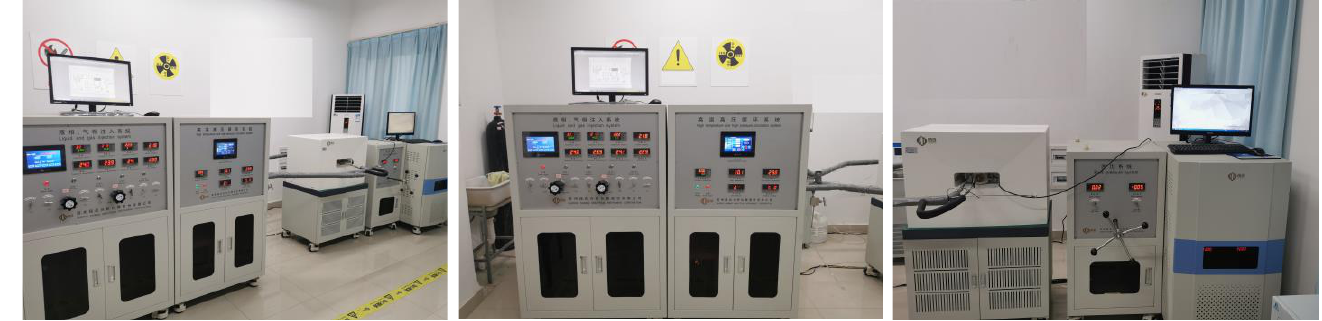
Figure 2. High-pressure NMR system (Suzhou Niumag Analytical Instrument Corporation). Table 5. NMR adsorption measurement parameters.